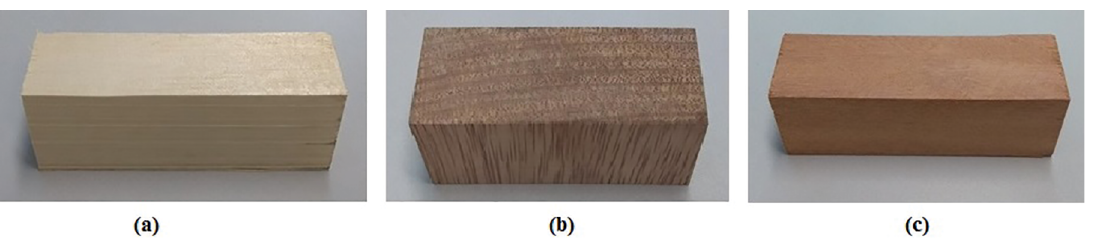
Figure 1. Specimens for the compression test: (a) Caixeta, (b) Cedroarana, and (c)